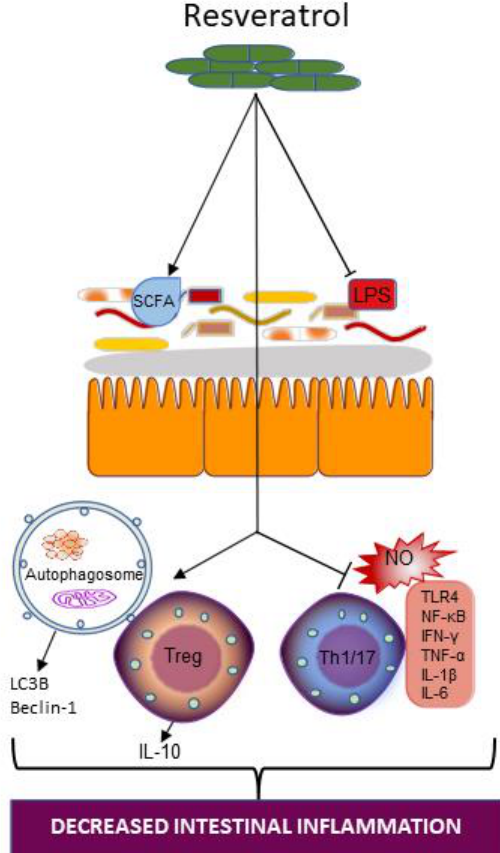
Figure 4. Action of fish oil supplementation on the intestinal ecosystem. Fish oil supplementation increases SCFA-producing microbes while decreasing LPS-producing gut bacteria. Fish oil supple- mentation may also encourage production of bioactive isomers of the anti-inflammatory polyun- saturated fatty acid (PUFA)-conjugated linoleic acid by the Bifidobacterium while inhibiting cytokine- mediated, proinflammatory pathways. These all lead to a reduction in intestinal inflammation. (SCFA, short chain fatty acid; LPS, lipopolysaccharide; PUFA, polyunsaturated fatty acid; IFN, in- terferon; TNF, tumor necrosis factor; IL, interleukin).